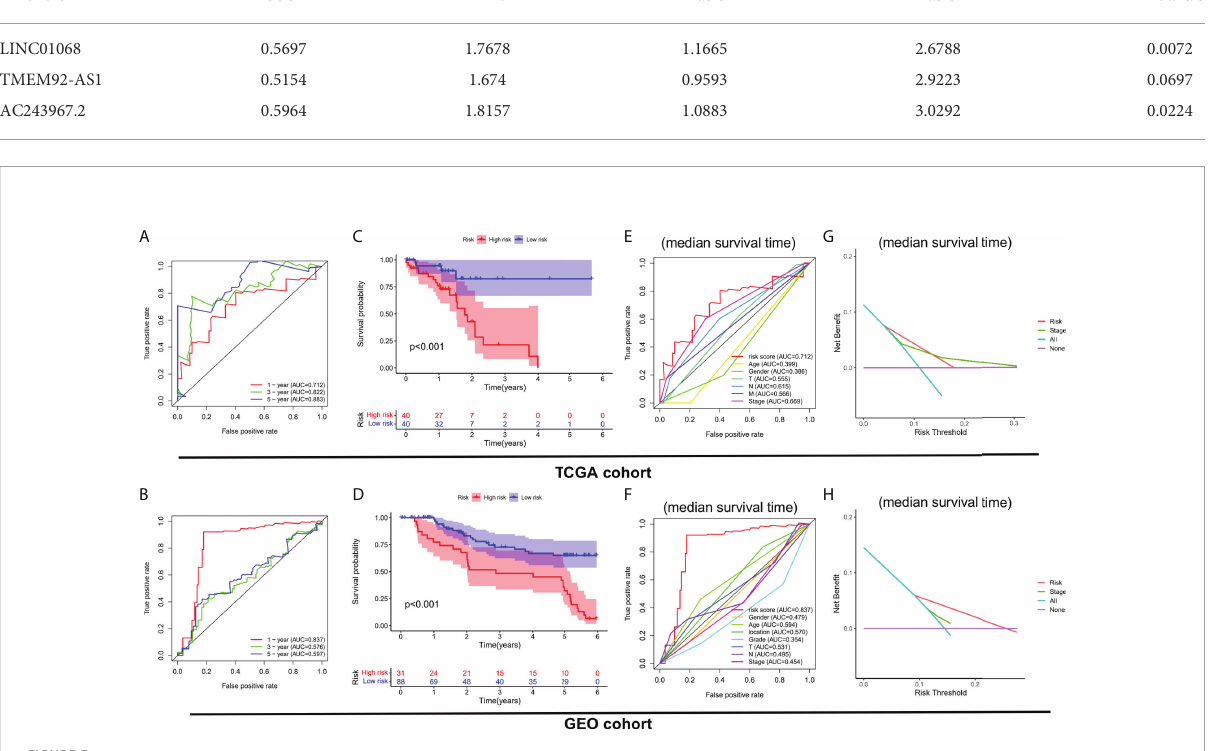
FIGURE 3 Clinical bene fi ts of the risk strati fi cation system. (A, B) Time-dependent ROC curves. (C, D) Kaplan-Meier analysis of high- and low-risk patients. (E, F) ROC curve analysis revealed the prognostic accuracy of risk mark and clinicopathological coef fi cients. (G, H) Decision curve analysis (DCA).